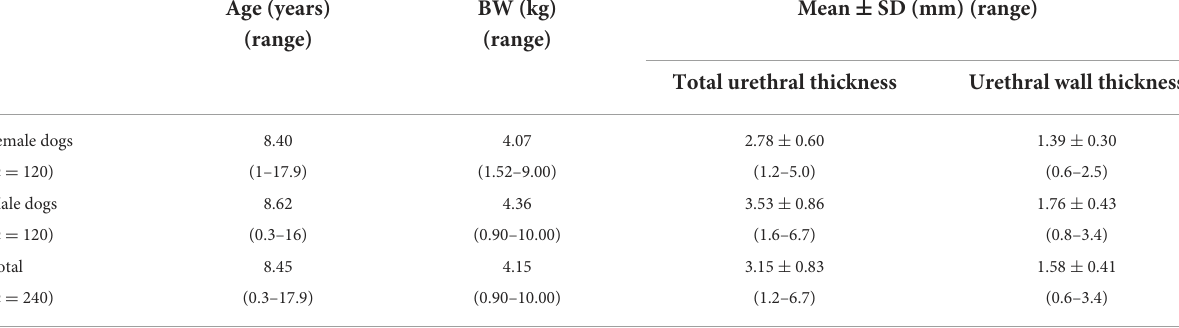
TABLE 1 Values of total urethral thickness and urethral wall thickness in female ( n = 120) and male dogs ( n =